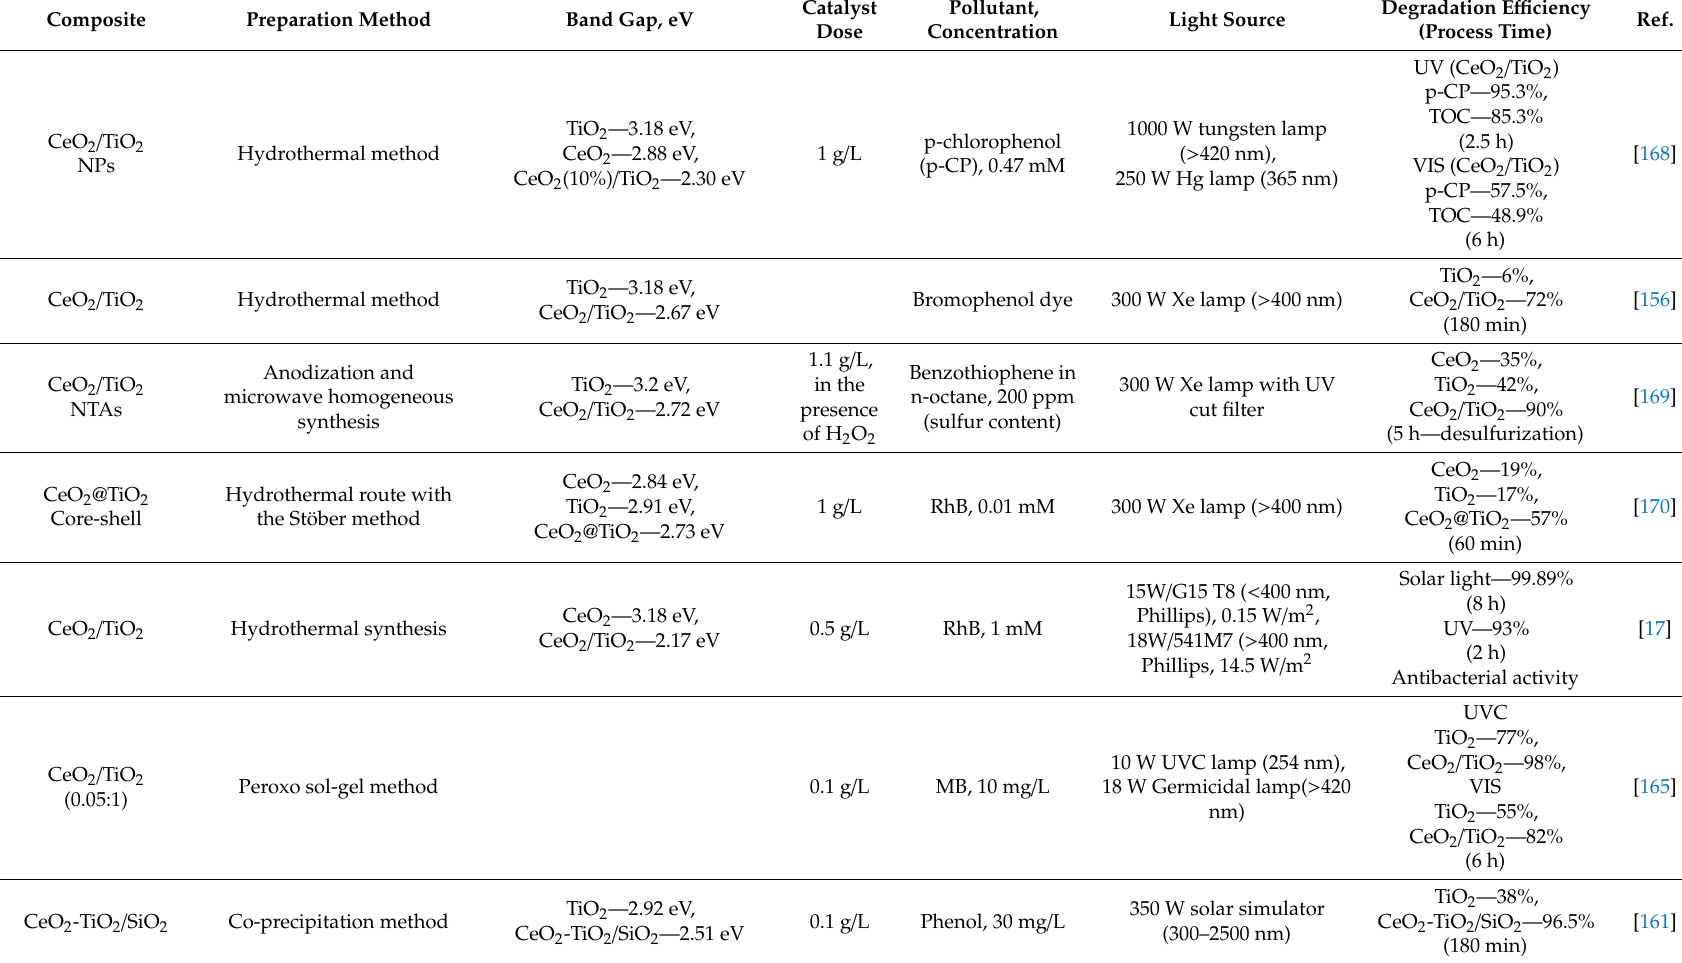
Table 3. Photocatalytic degradation of various pollutants with the application of CeO 2 composites with TiO 2 as photocatalytic